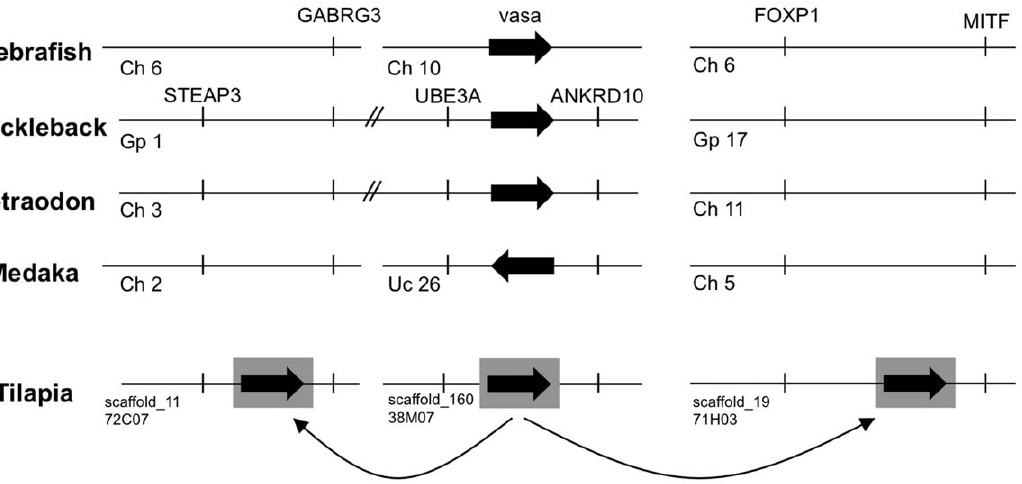
Figure 6. Nile tilapia has one ancestral and two recent duplicate vasa loci. This study reveals that Nile tilapia has at least three vasa loci with one original and two extra loci for vasa gene. In these duplications, only a small region encompassing the vasa gene was duplicated from the original site and integrated into novel sites.